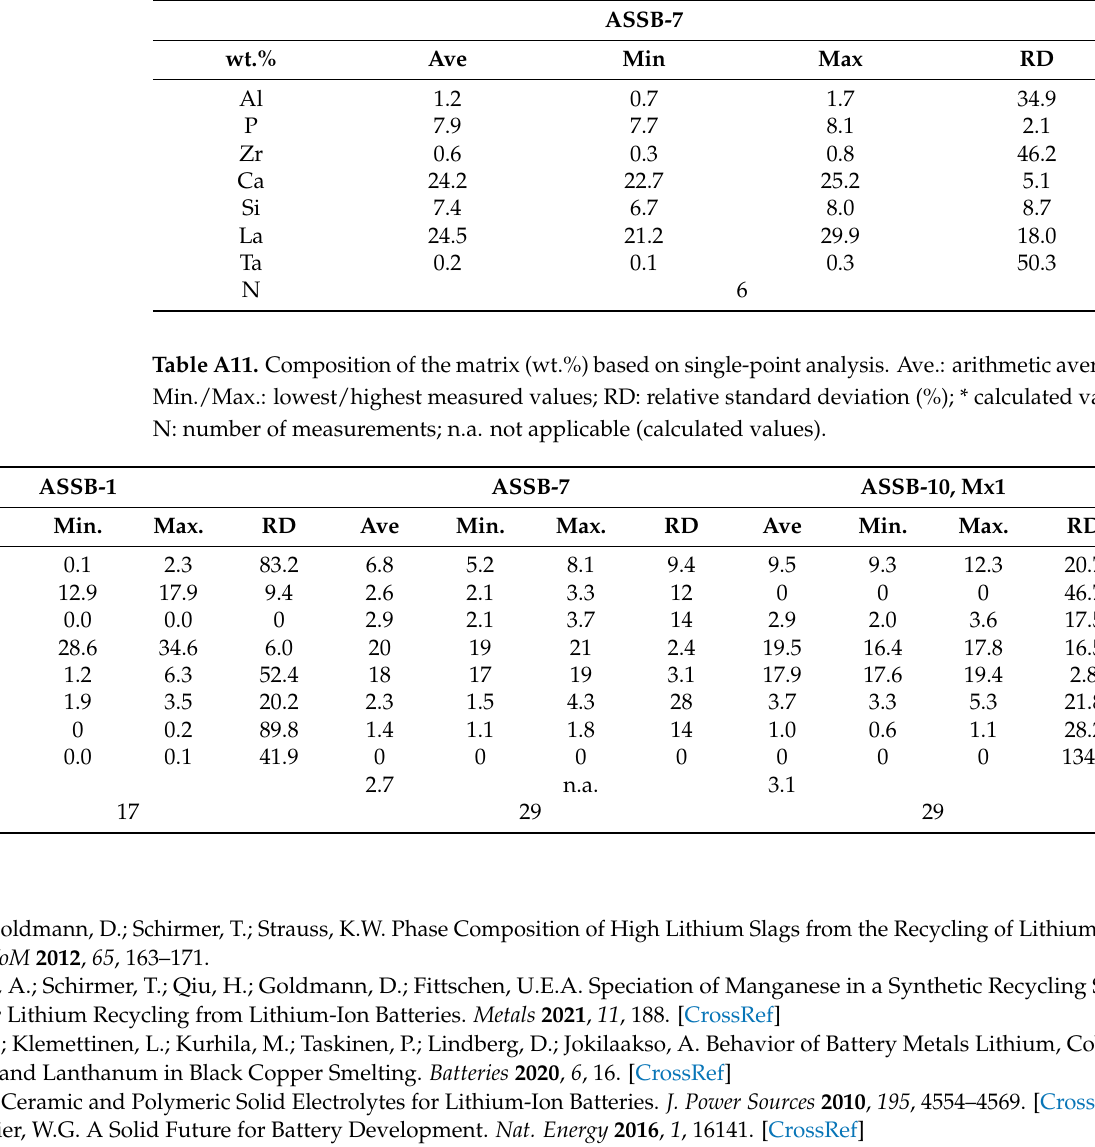
Table A10. Composition of Bphs (wt.%) based on single-point analysis (only ASSB-7). Ave.: arithmetic average; Min./Max.: lowest/highest measured values; RD: relative standard deviation (%);N: number of measurements.